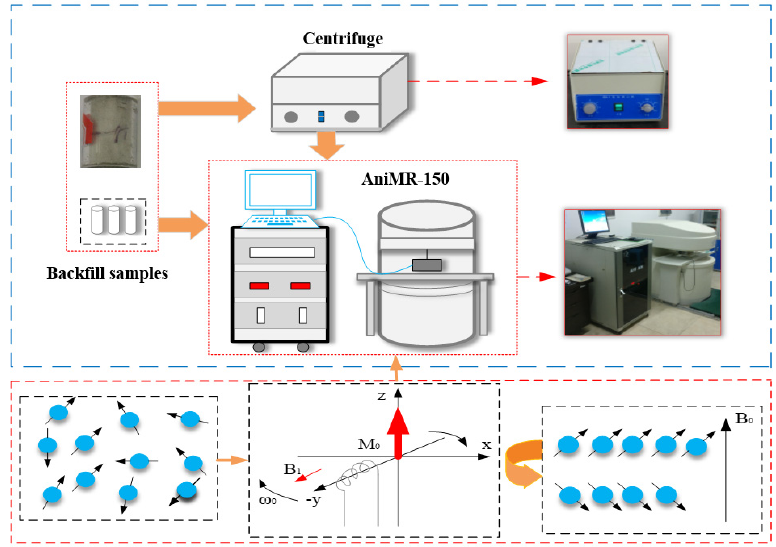
Figure 5. Nuclear magnetic resonance (NMR) test principle and field test device.